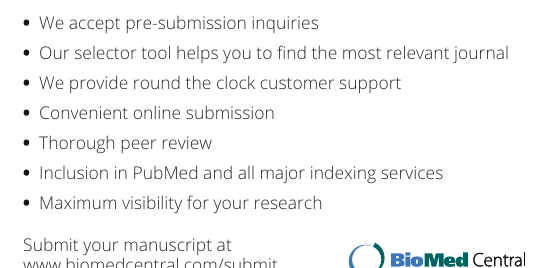
82. East African Community. Report on the 9th ordinary meeting of the EAC sectoral council of ministers of health. EAC/SCM/HEALTH/001/2014. Arusha: East African Community; 2014. http://www.health.eac.int/index.php?option= com_docman&task=doc_download&gid=73&Itemid=6. Accessed 24 Oct 2015 83. Rwirahira R. EAC members to adopt common healthcare system for the region. The east African. 2012.